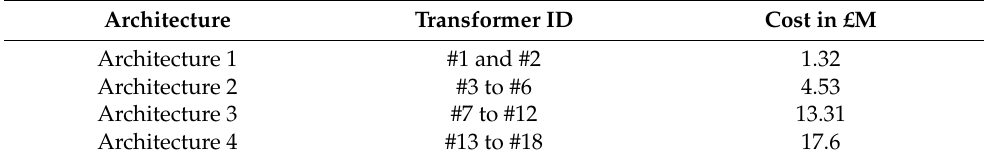
Table 12. Transformers’ cost estimation.